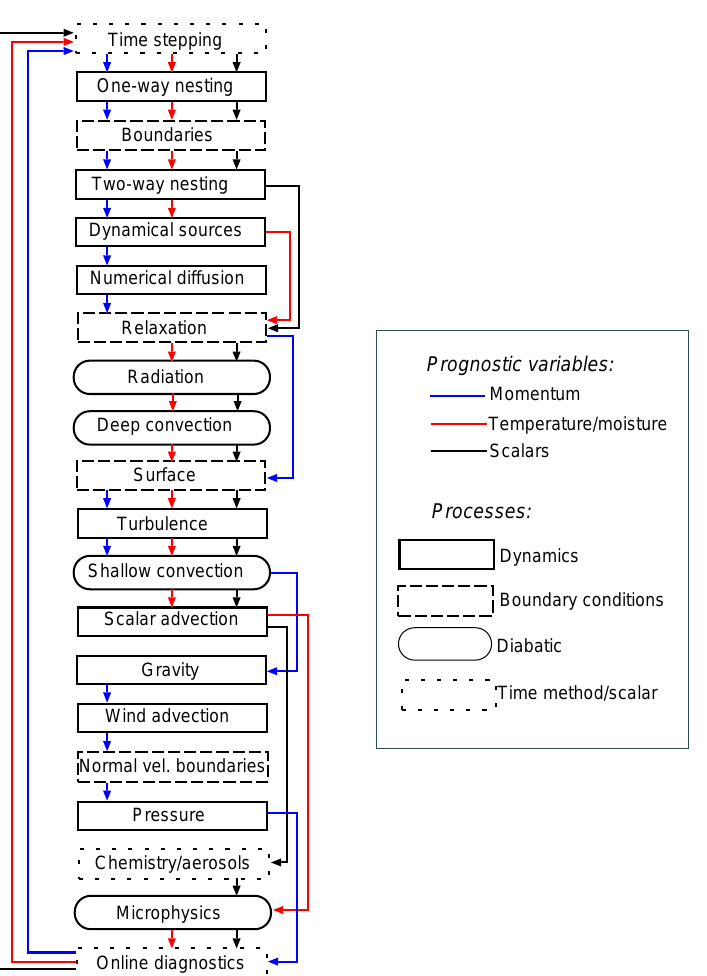
Figure 2. Flowchart of one integration time step of the simulation. The boxes represent the type of process, and the outline color represents the flows of the different types of